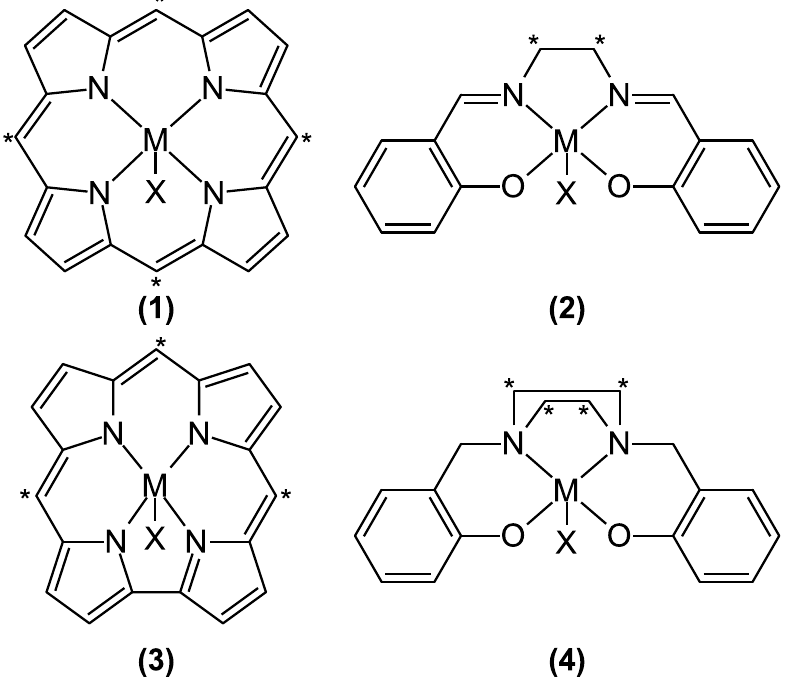
Figure 1. General structures of metalloporphyrin ( 1 ), metallosalen ( 2 ), metallocorrole ( 3 ) and metallo-bis-amino-phenolate ( 4 ) complexes, in which M = Mn, Fe. Positions and/or groups marked with an asterisk (*) are usually responsible for providing chirality to the complex, via the introduction of chiral